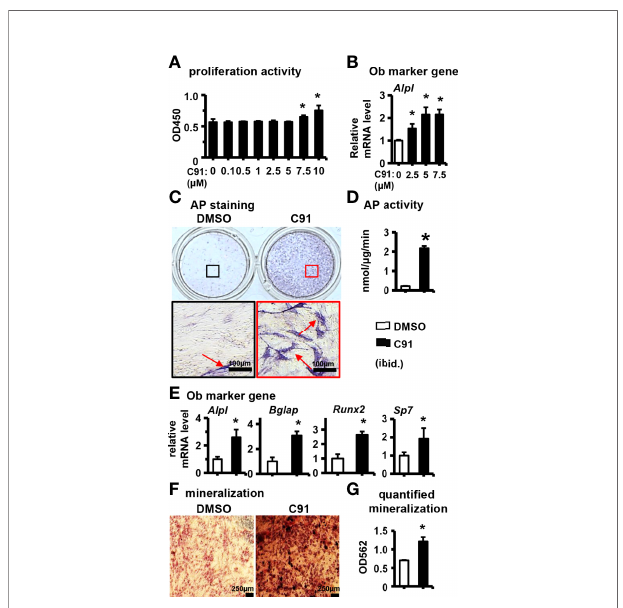
FIGURE 1 | The effect of C91 on ST2 cell differentiation and mineralization. (A) The effect of C91 on the proliferation activity of ST2 cells was detected by CCK8 assay. Results are expressed as relative OD450 values, calculated by normalizing OD450 readings to the mean value of the control group. C91 at concentrations of 0.1 – 5 m M had no signi fi cant effect on the viability of ST2 cells. (B) qRT-PCR detection of mRNA expression of early osteogenesis marker gene Alpl . ST2 cells were treated with C91 (5 m M) for 3 days, followed by AP staining (C) analysis and AP biochemical quanti fi cation (D) analysis. Red arrows indicate alkaline phosphatase staining positive cells. Scale bar = 100 m m. (E) The mRNA expression levels of osteogenic target genes were detected by qRT-PCR. (F) ST2 cells were treated with C91 for 14 days, and the osteogenic induction medium was changed every two days in between. Alizarin Red S staining was performed (original magni fi cation, x4). Red arrows indicate mineralized nodules, scale bar = 250 m m. (G) is the quantitative analysis result of panel (D) Results are presented as mean ± SD (n = 3 per group). * indicates P < 0.05, compared with the DMSO